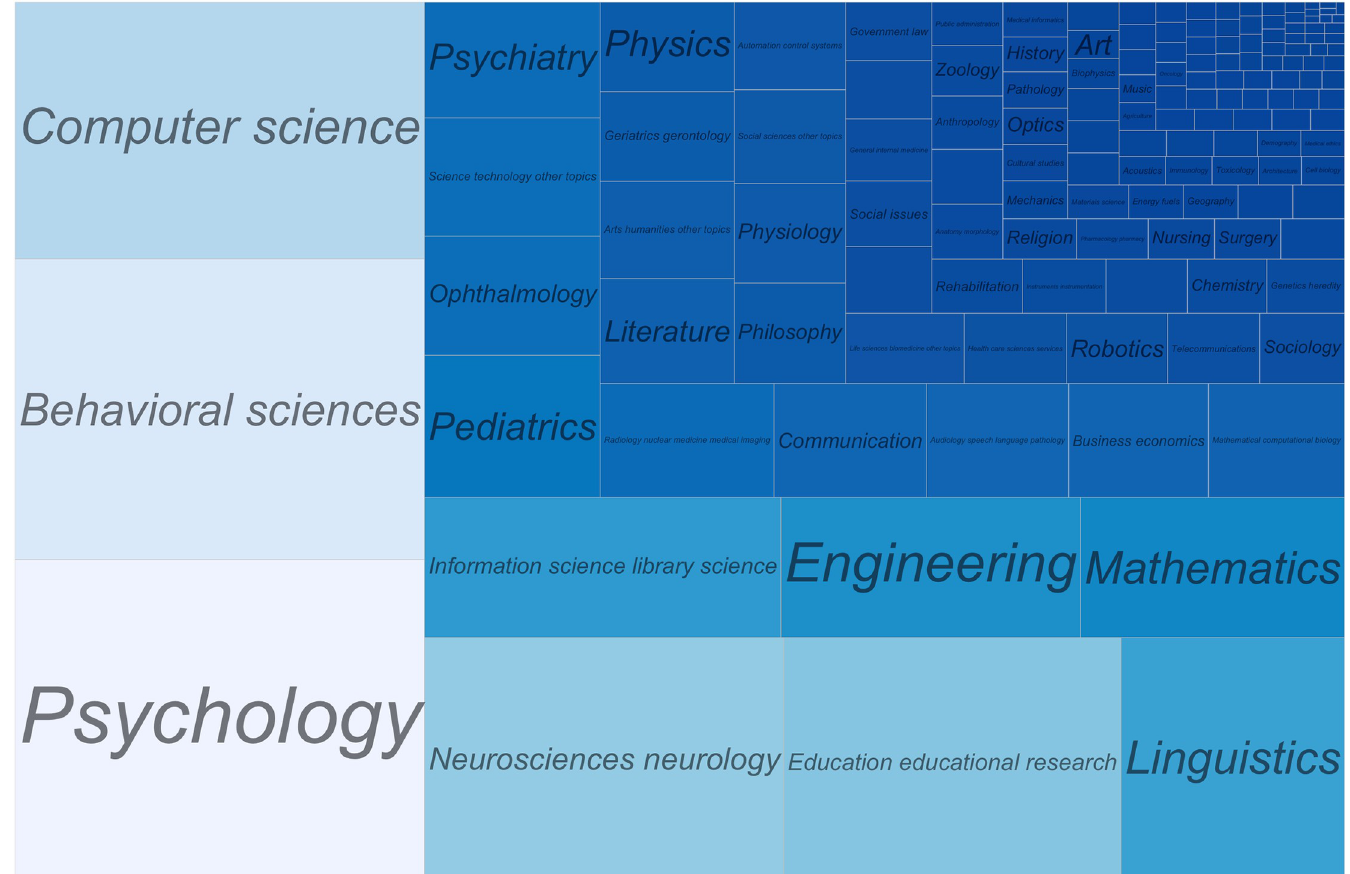
Fig 1. Publications on abstract and concrete concepts or words cover a wide range of disciplines. sizes of the blocks roughly correspond to proportions of publications in different disciplines.